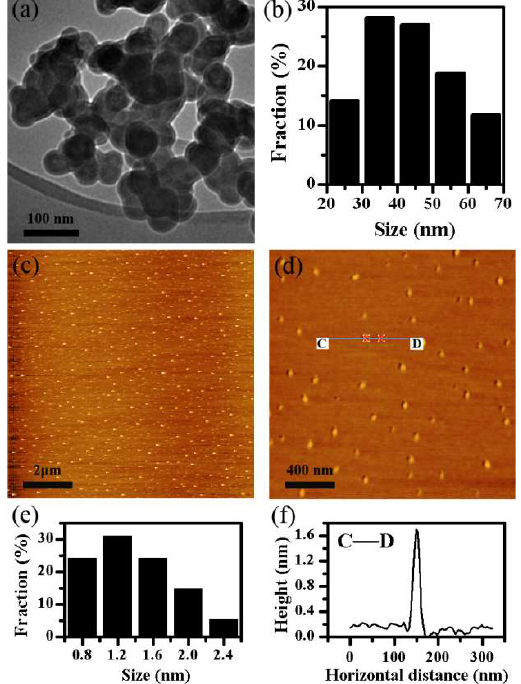
Figure 3. TEM image ( a ), and the corresponding size distribution ( b ), of CNDs; AFM images of CNDs with different magnifications ( c , d ), and their height distribution ( e ) and height profile along the line CD ( f ).